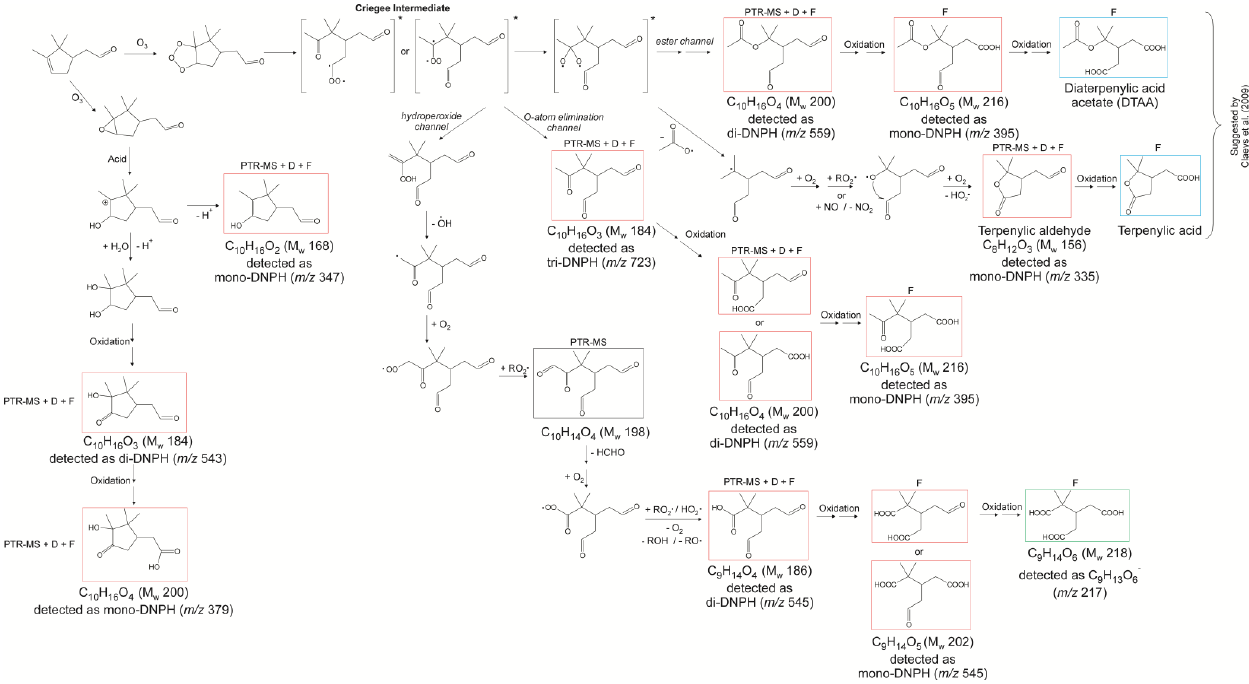
Fig. 2b. Proposed ozonolysis pathways from campholenic aldehyde leading to the detected compounds. The oxidation products identified with authentic standards are shown in blue boxes, those detected by the DNPH method are shown in red boxes, the compound shown in the black box was solely detected by PTR-MS measurements in its protonated form, and the proposed tricarboxylic acid in the green box was detected from direct filter extract analysis. (Abbreviations: D=detected from denuder analysis; F=detected from filter analysis.)